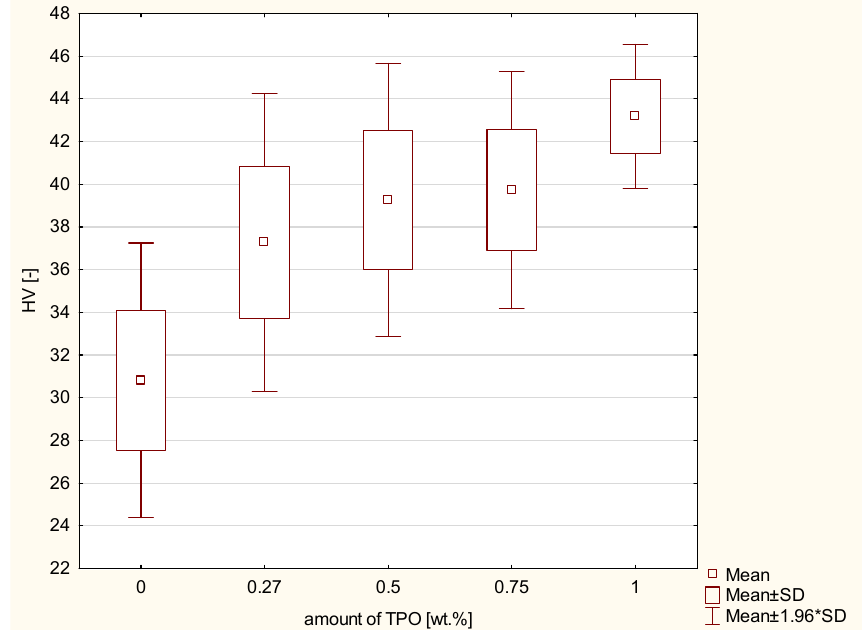
Figure 1. Box-and-whisker plot of Vicker’s hardness of composites containing CQ or TPO as pho- toinitiator; photopolymerization both side of samples 20 s per 2 mm thickness of composites with Valo lamp light intensity 1450 mW/cm 2 .